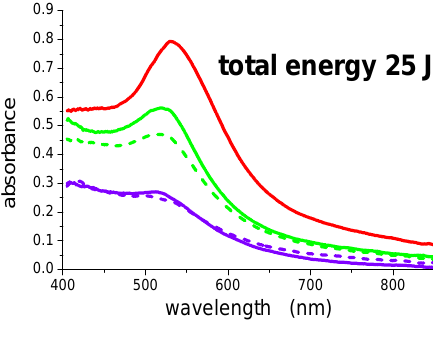
Figure 4. On-line UV-Vis spectra of a suspension of AuNPs obtained by ablation with 1,064 nm, 15 mJ before (solid red curve) and after post-irradiation with different wavelengths. Green curves: 532 nm, 5 mJ, 5,000 shots (solid) and 10 mJ, 2,500 shots (dashed). Violet curves: 355 nm 5 mJ, 5,000 shots (dashed) and 10 mJ, 2,500 shots (solid). OPL = 1